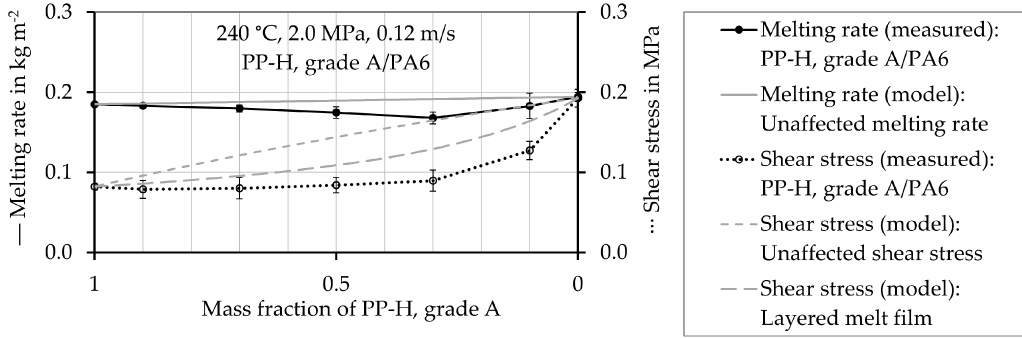
Figure 9. Measured and estimated values of the melting rate and shear stress of the mixture of PP-H, grade A, and PA6 at a temperature of 240 °C.